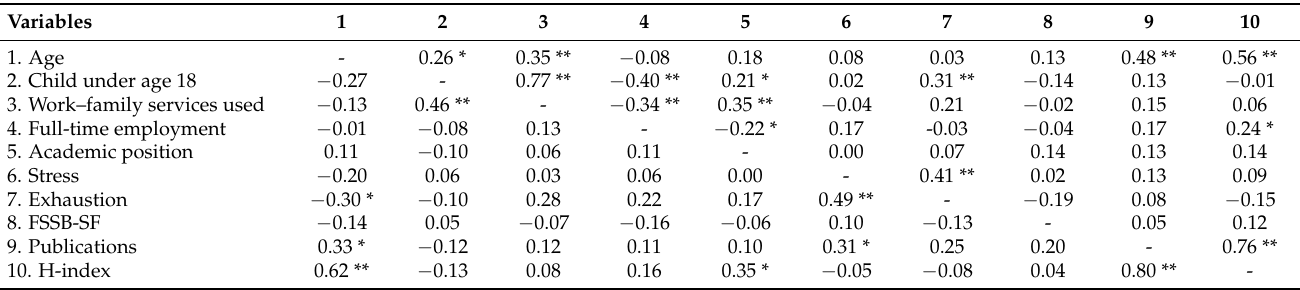
Table 3. All correlation